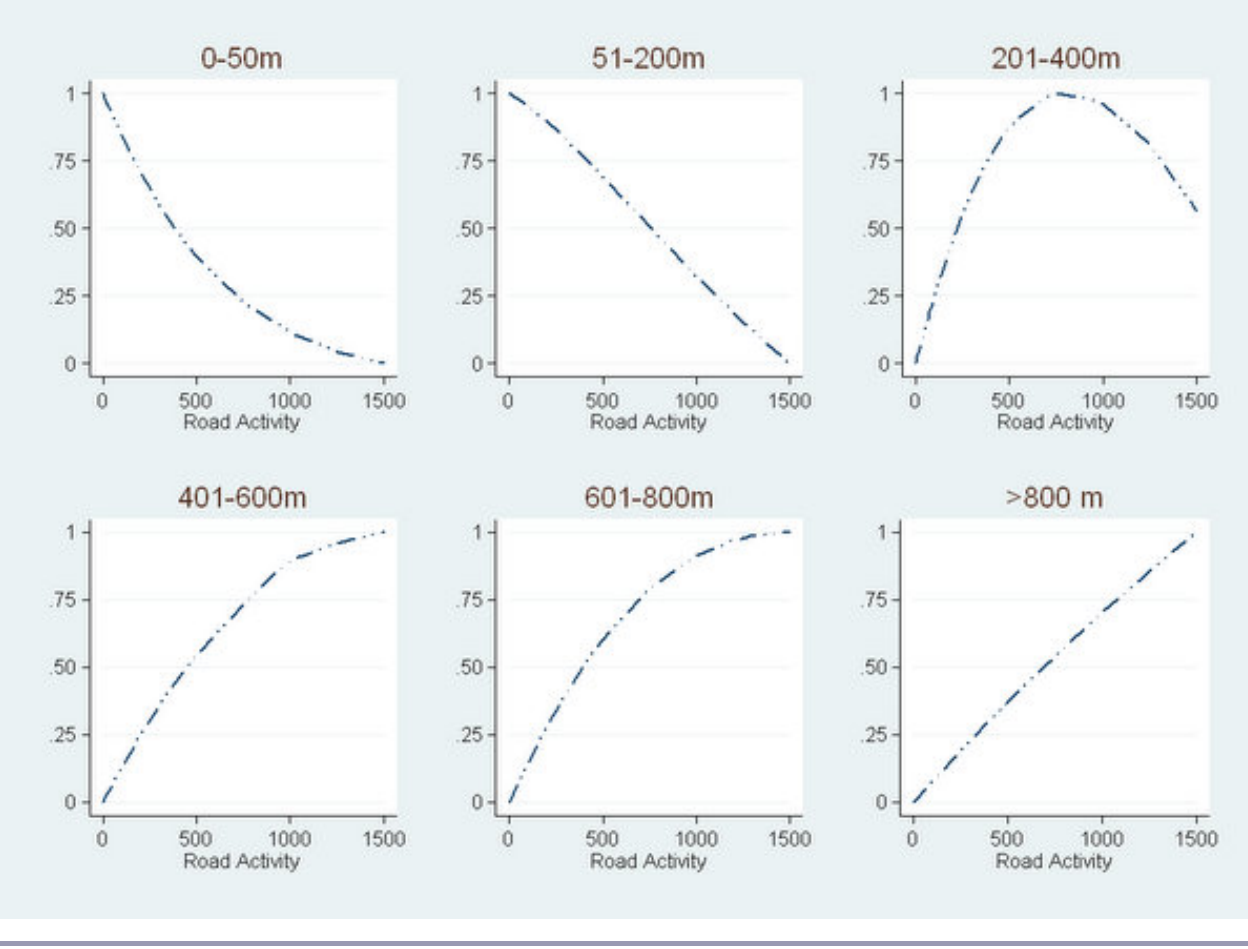
Fig. 3. Graphs of the change in wolf relative probability of use as a function of increasing road activity within six ‘distance-to-road’ categories. The x-axis is hourly road activity and y-axis is relative probability of use. A linear stretch was used to scale the predicted values between 0 and 1 following Johnson et al.